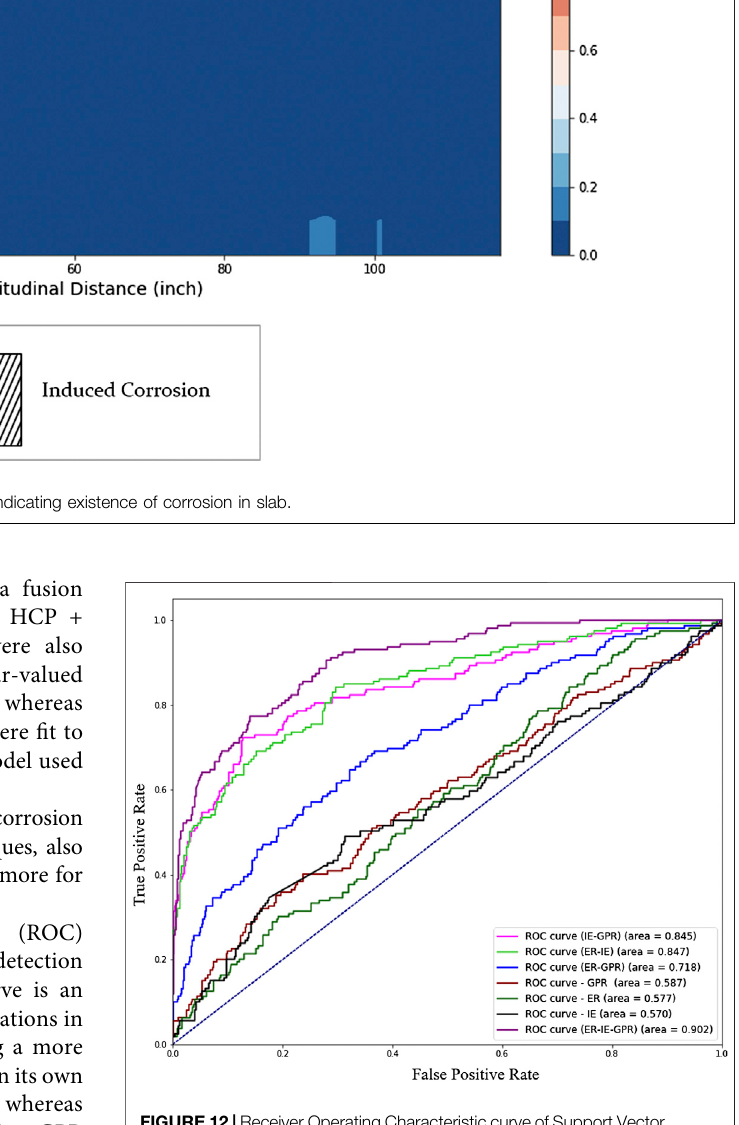
FIGURE 12 | Receiver Operating Characteristic curve of Support Vector Machine classi fi ers for delamination